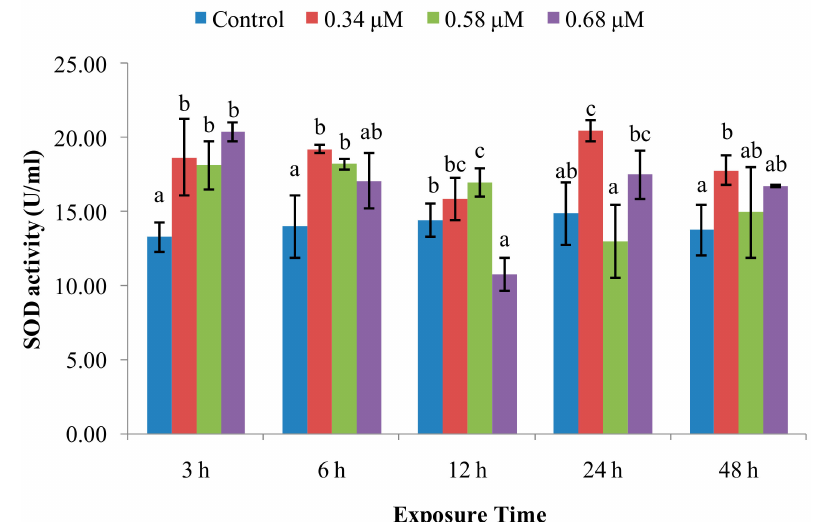
Figure 1. E ff ect of TD 49 on hemolymph superoxide dismutase (SOD) activity at di ff erent time points after exposure to di ff erent concentrations (0, 0.34, 0.58, 0.68 µ M) of TD 49 . Data represent mean ±